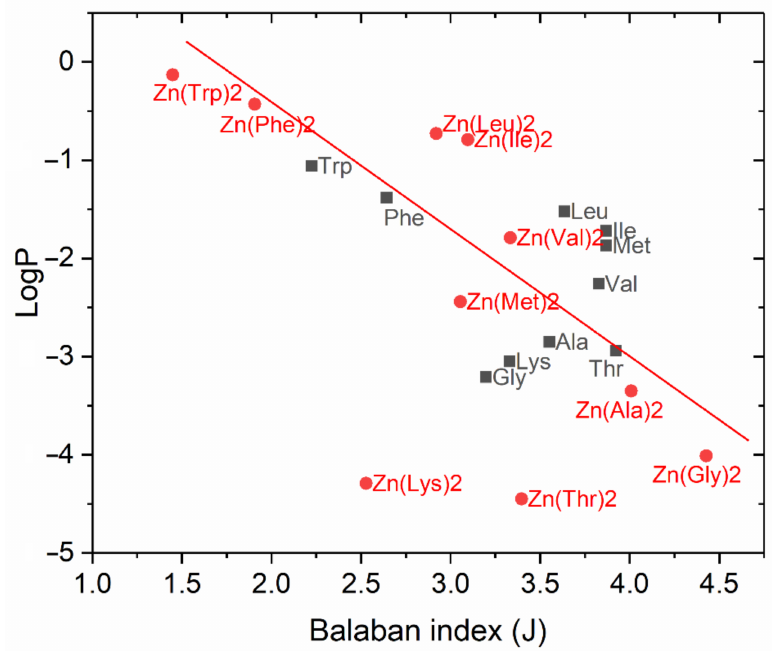
Figure 2. Dependence of lipophilicity on Balaban index for amino acids and their chelate compounds with